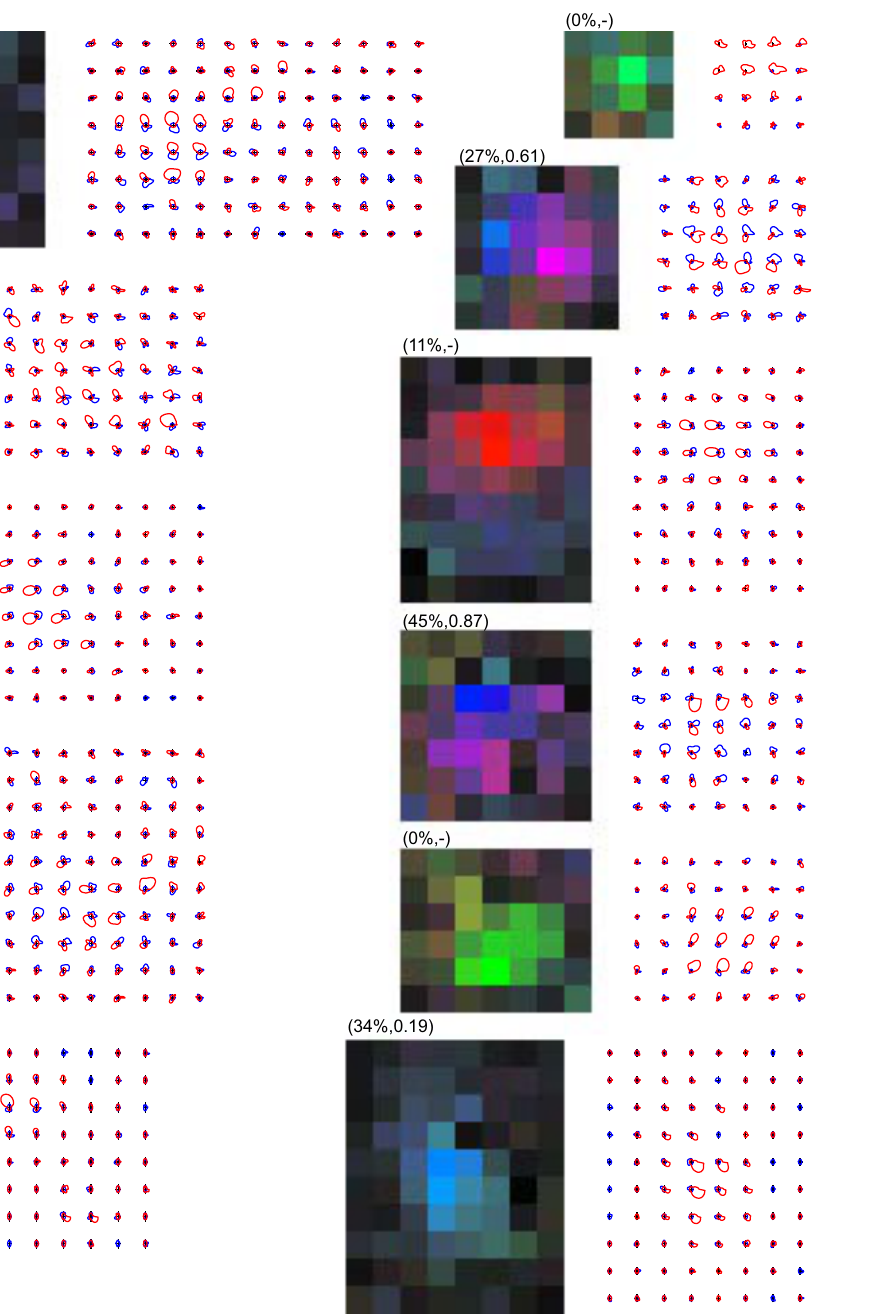
percent missing and the valley-over-peak ratio for that specific neuron (See Materials and Methods, and the “Multiple Peaks” section for an explanation of these measures).These examples show that there is a wide range of preferred direction distributions, as well as a wide range of excitatory and suppressive interactions within the RF of MT neurons. In our sample, 38% of neurons had two or more preferred directions within their excitatory RF. non-linear interaction between different locations in the RF or between center and surround because they were found even when those locations were stimulated with only one dot at a